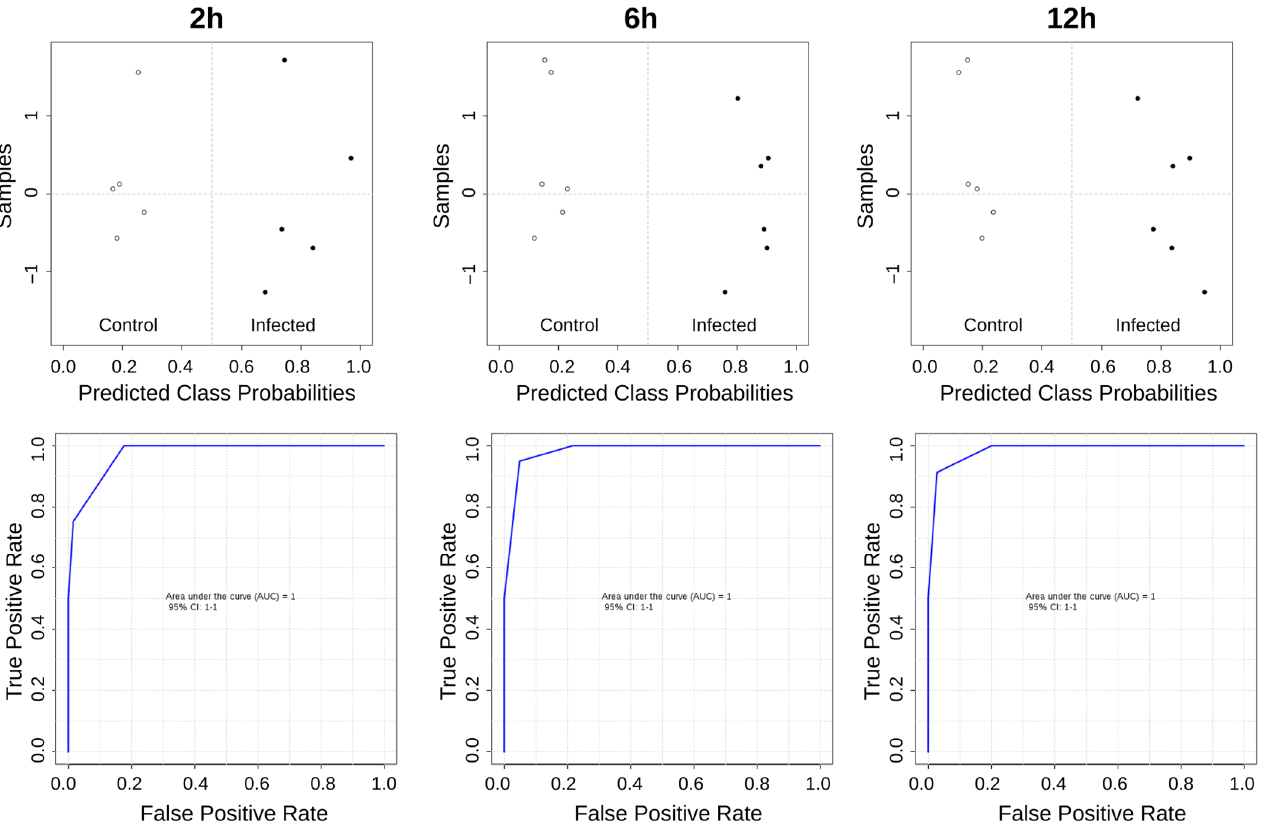
Figure 5. SVM classification error of MAYV infected cells. Assessment of model quality through classification using SVM. Classification error is related to the robustness of the metabolites identified in the chemometric analysis in predicting a metabolic profile in control or infected cell. The classification error reduces according to the progress of the infection process.